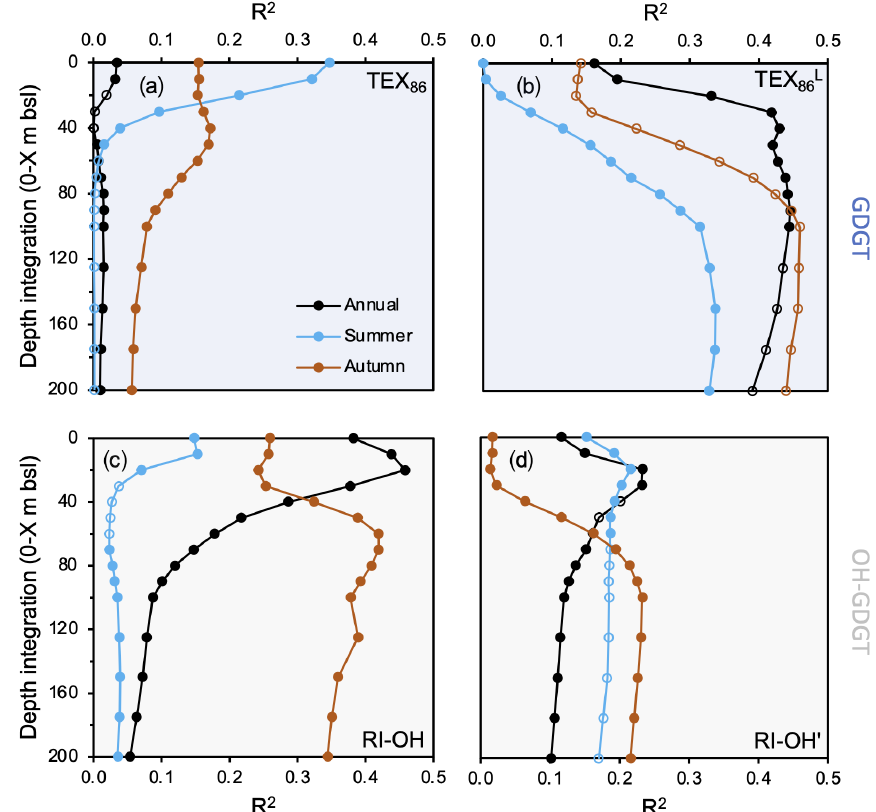
Figure 7. Regression coefficients of GDGT-based temperature indices against WOA18 temperature at various depth integrations and seasons for this study’s dataset ( n = 13). (a) TEX 86 , (b) TEX L , (c) RI-OH, and (d) RI-OH (cid:48) . WOA18 data are from Locarnini et al. (2018). Data 86 points that are not filled indicate insignificant correlations ( p value >